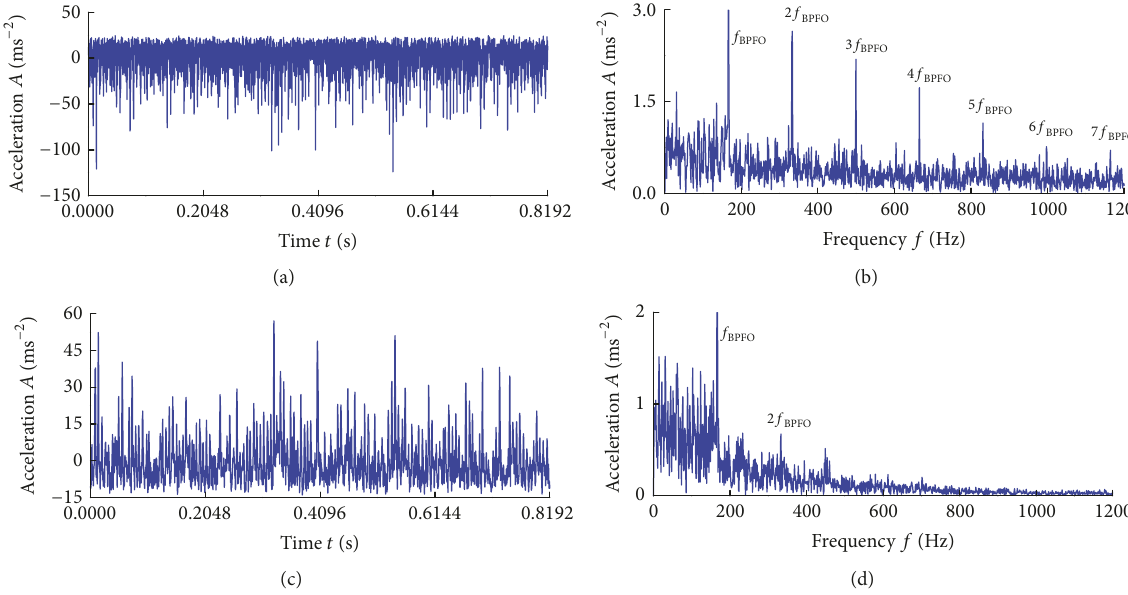
Figure 11: The intrinsic envelopes extracted by the manifold with Isomap and their envelope spectra: (a) IMFs-envelope space of EEMD, (b) the envelope spectra of (a), (c) multiscale envelope space of WPT, and (d) the envelope spectra of